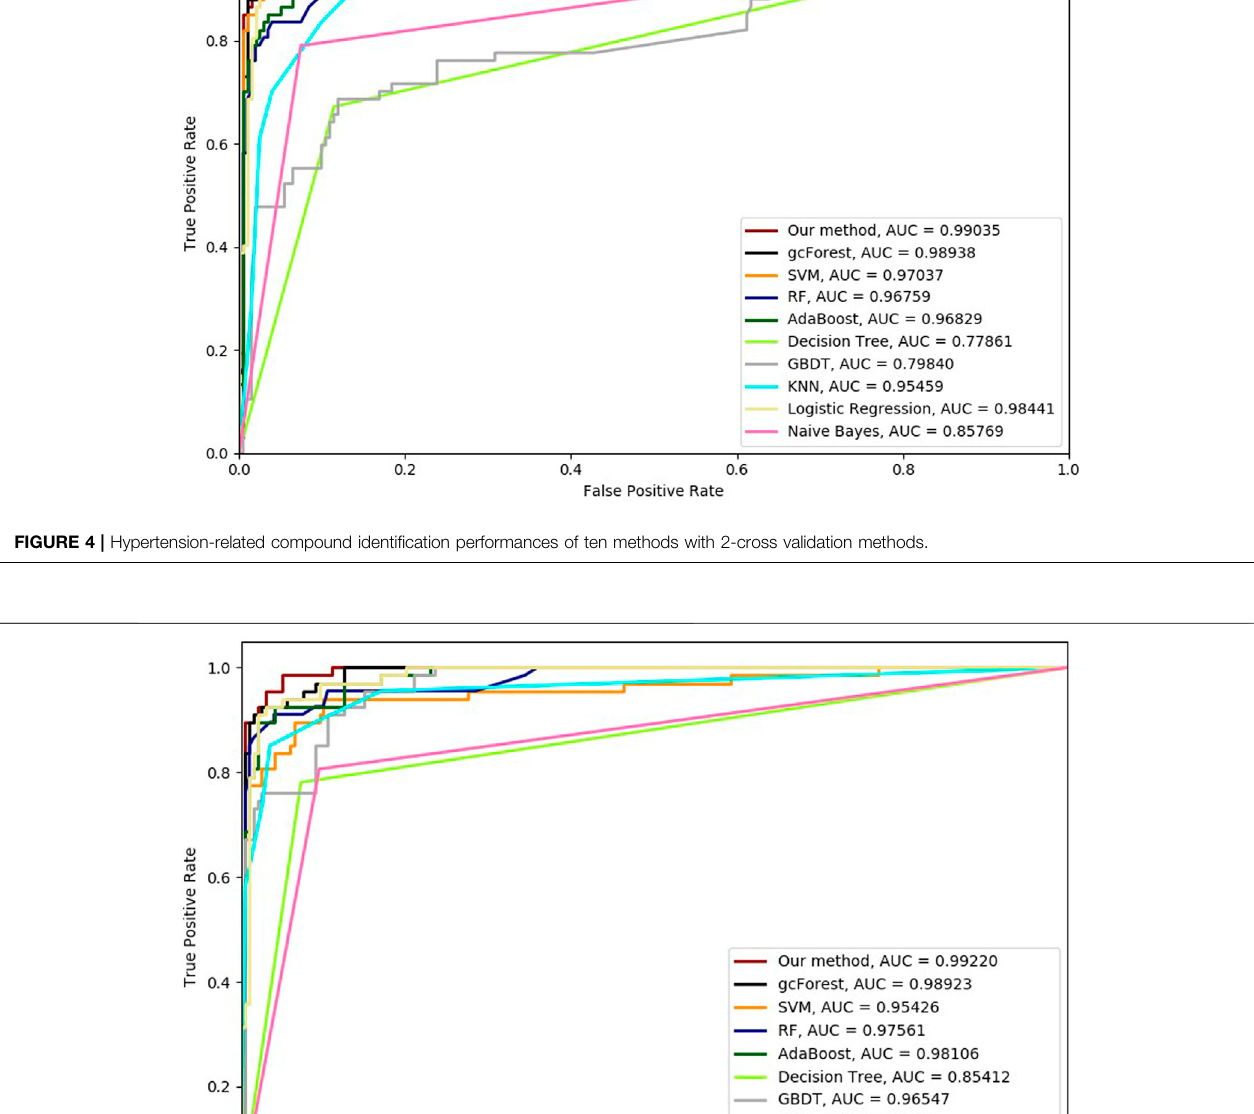
Frontiers in Genetics |